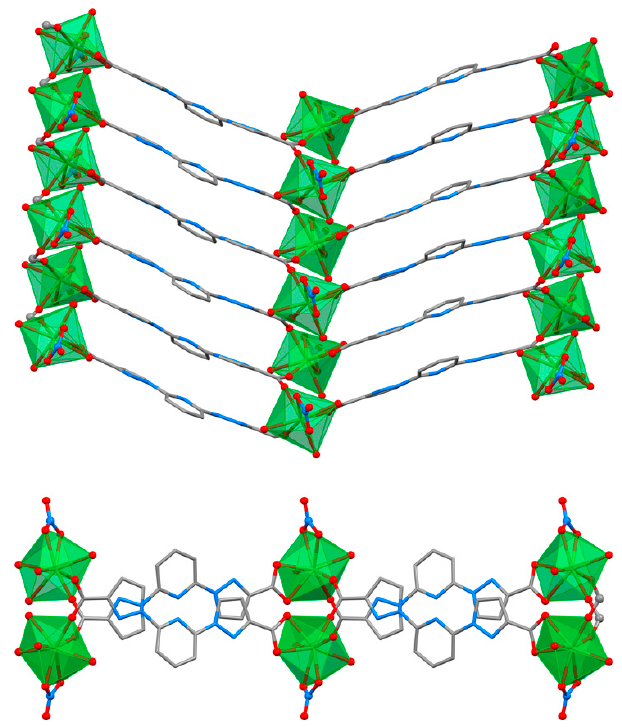
Figure 1. Layer of [YbL 3 (NO 3 )(H 2 O) 2 ] n in YbL 3 : perpendicular view ( top ) and lateral view ( bottom ).